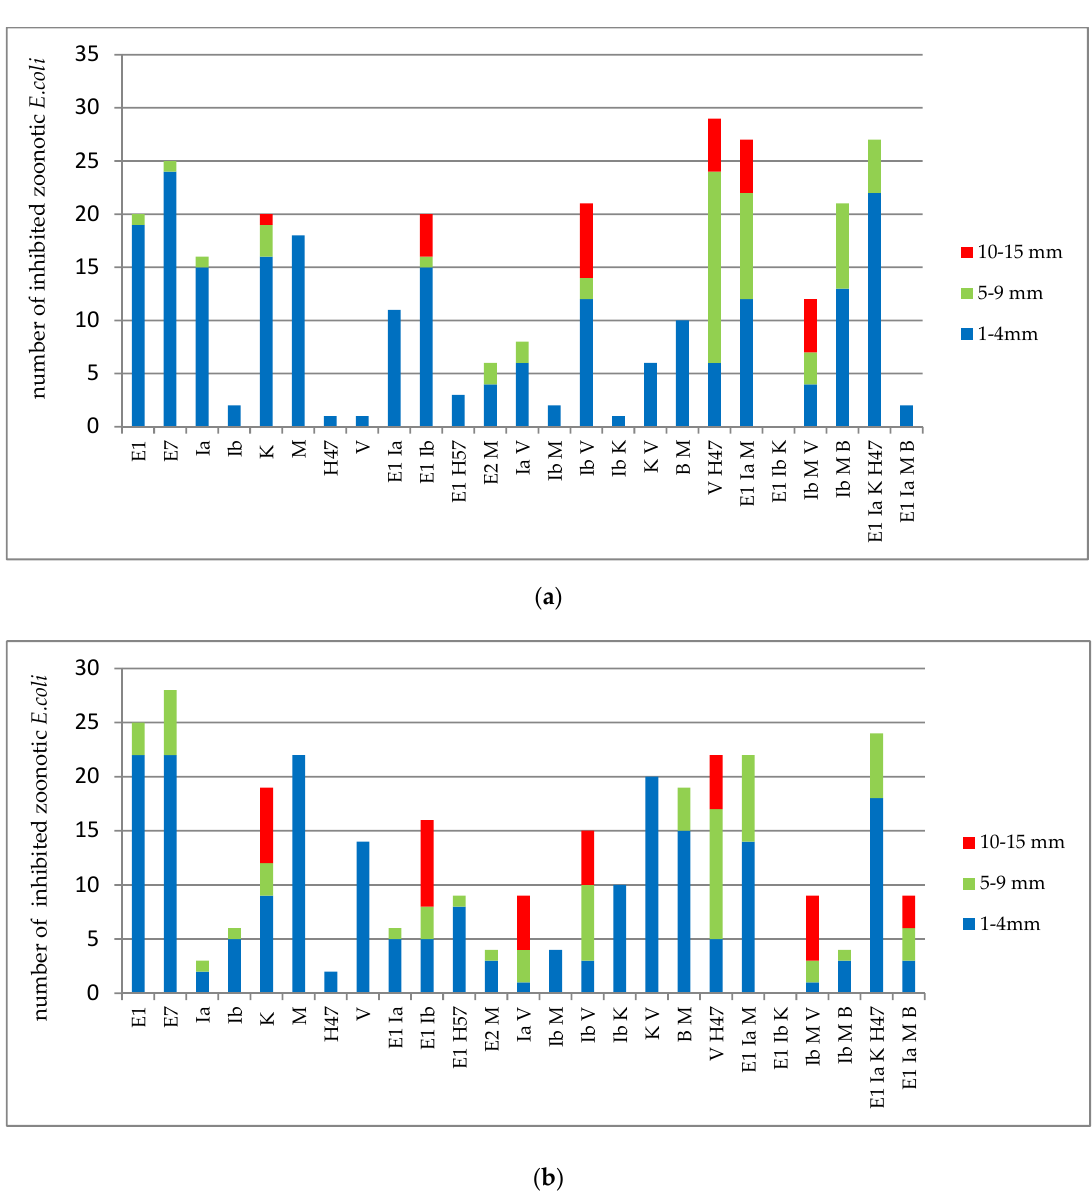
Figure 1. Differential bactericidal activity of bacteriocins produced by human E. coli strains expressed as the magnitude of the growth inhibition zone for antibiotic-sensitive ( a ) and -resistant ( b ) zoonotic E. coli strains.